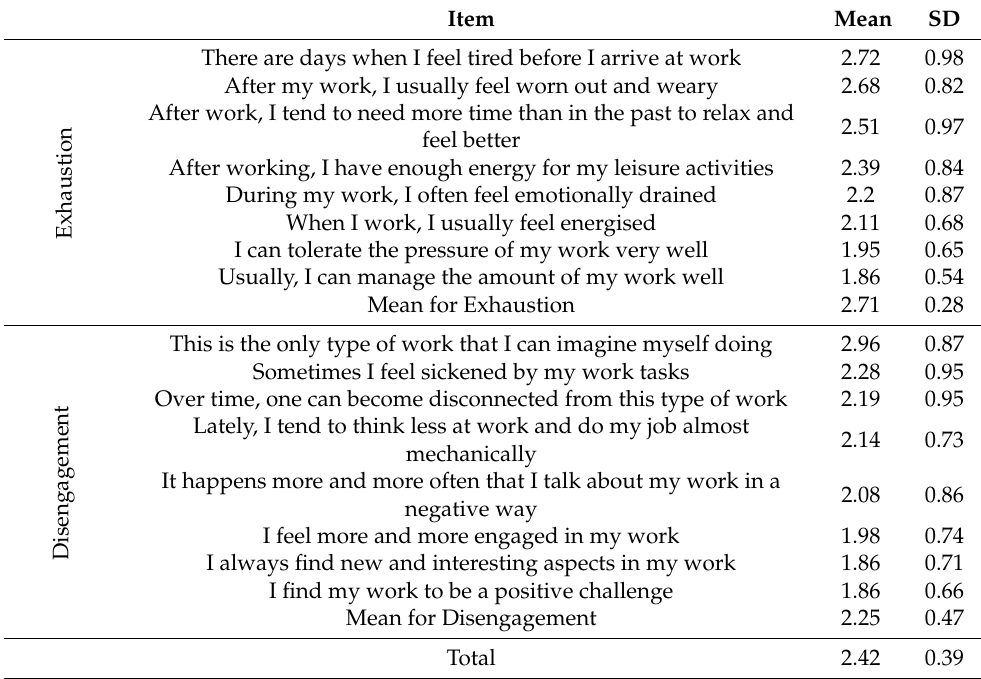
Table 3. Descriptive statistics related to burnout ( n = 133).